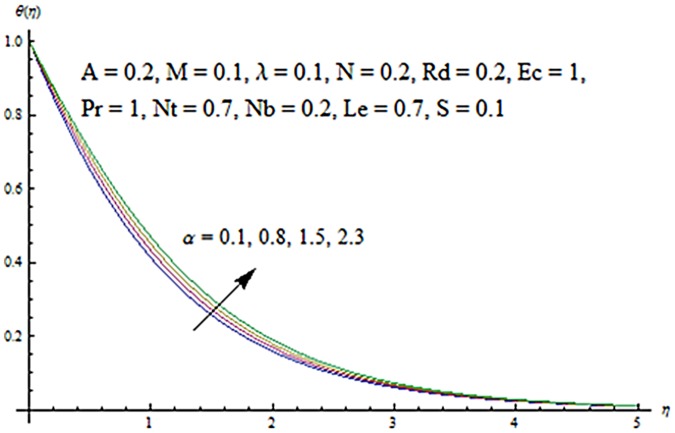
Influence of α on θ.